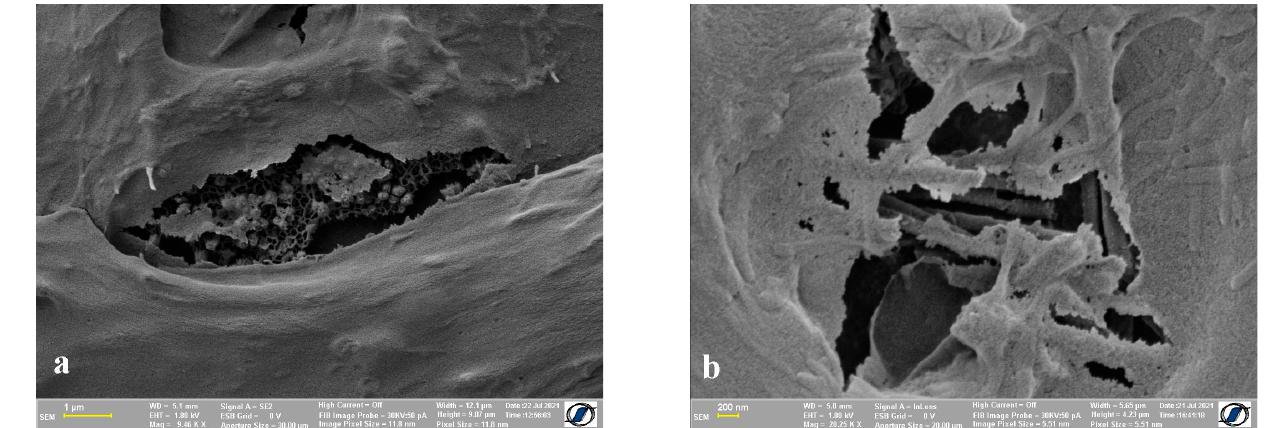
Figure 7. SEM imaging with ( a ) ADSC and ( b ) HOS exhibiting membrane disruption.